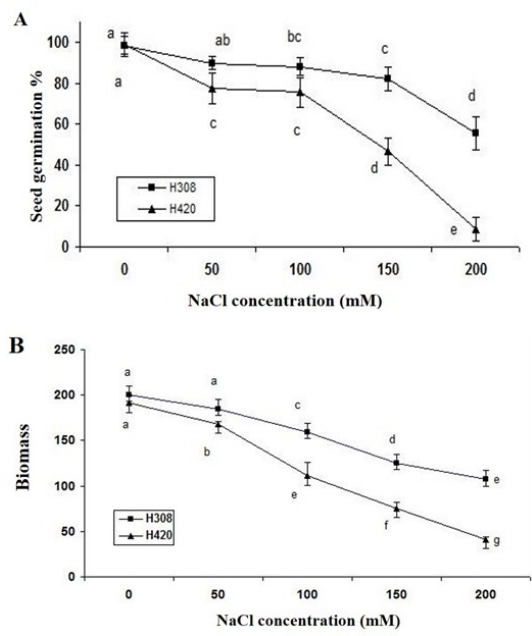
Fig. 1. The effect of various salt concentrations on the seed germination (A) and biomass (B) of two canola genotypes (H420 and H308).Values are mean ± SE (n=3). Means followed by the same letter did not significantly differ at P ≤0.05 according to Duncan’s multiple range tests.